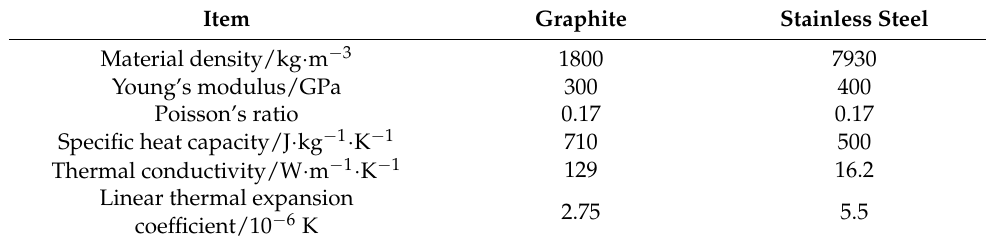
Table 2. Material performance parameters of seal rings [35].